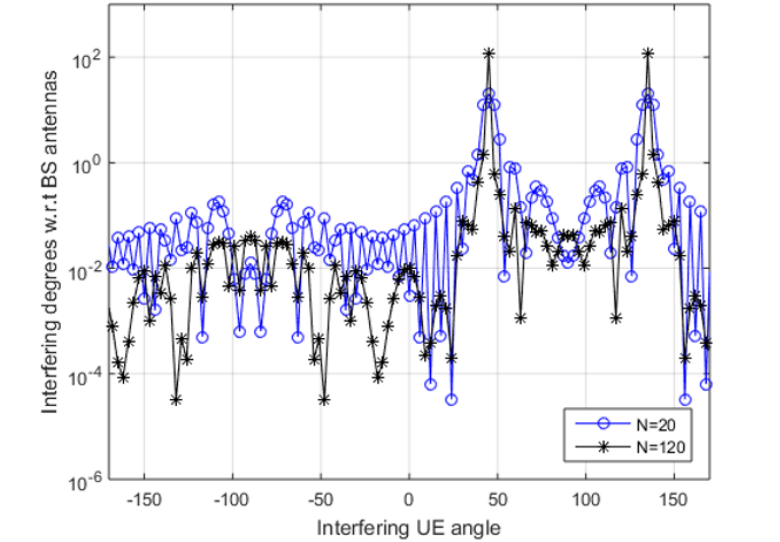
Figure 7. Desired signal, interference from other cell and noise added to the signal during